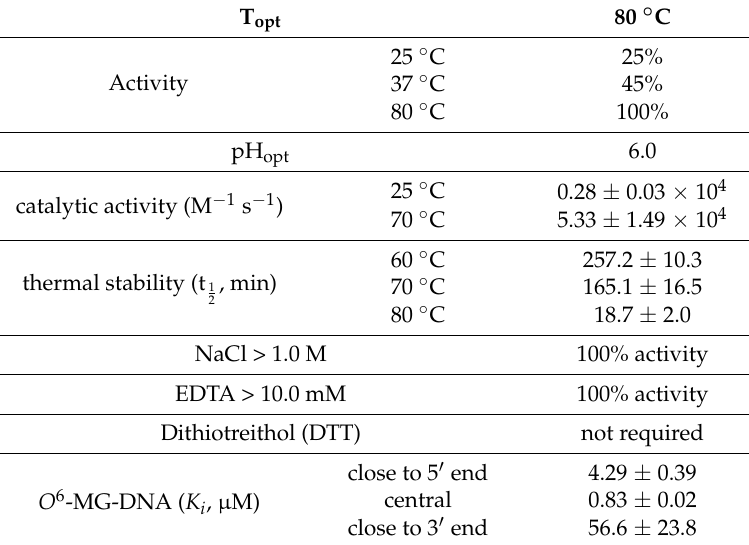
Table 1. Biochemical properties of S. solfataricus OGT ( Ss OGT), using SNAP-Vista Green ® as substrate (data are from